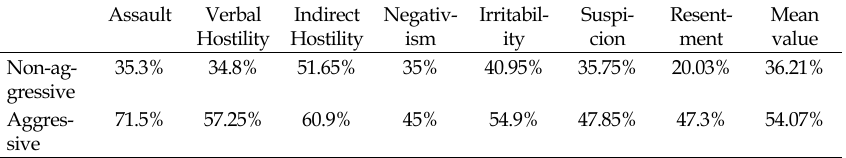
Table 2. Results from the Buss-Durkee inventory Assault Verbal Indirect Negativ- Irritabil- Suspi- Resent- Mean Hostility Hostility ism ity cion ment value Non-ag- 35.3% 34.8% 51.65% 35% 40.95% 35.75% 20.03% 36.21% gressive Aggres- 71.5% 57.25% sive